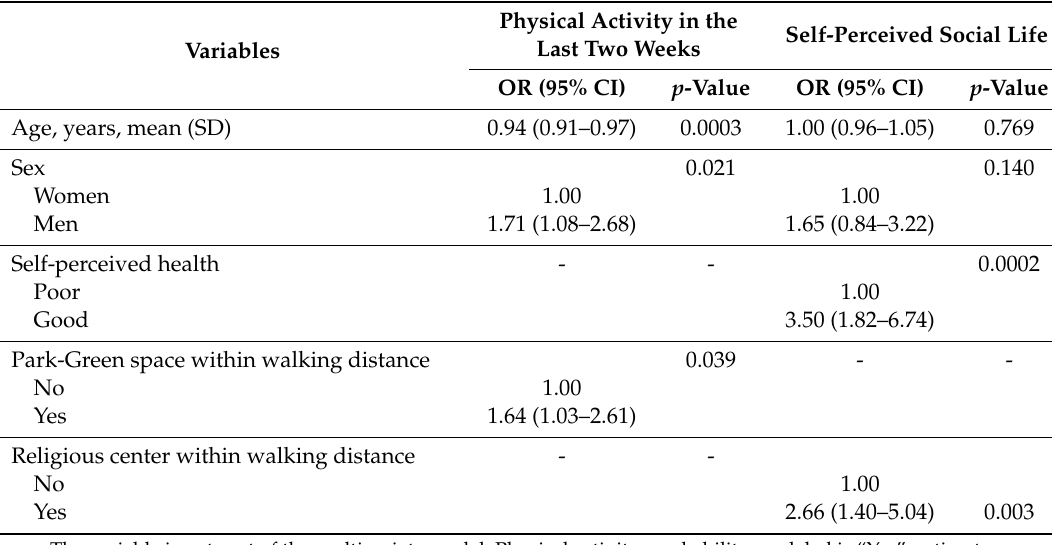
Table 2. Factors associated with physical activity and self-perceived social life in functionally independent older